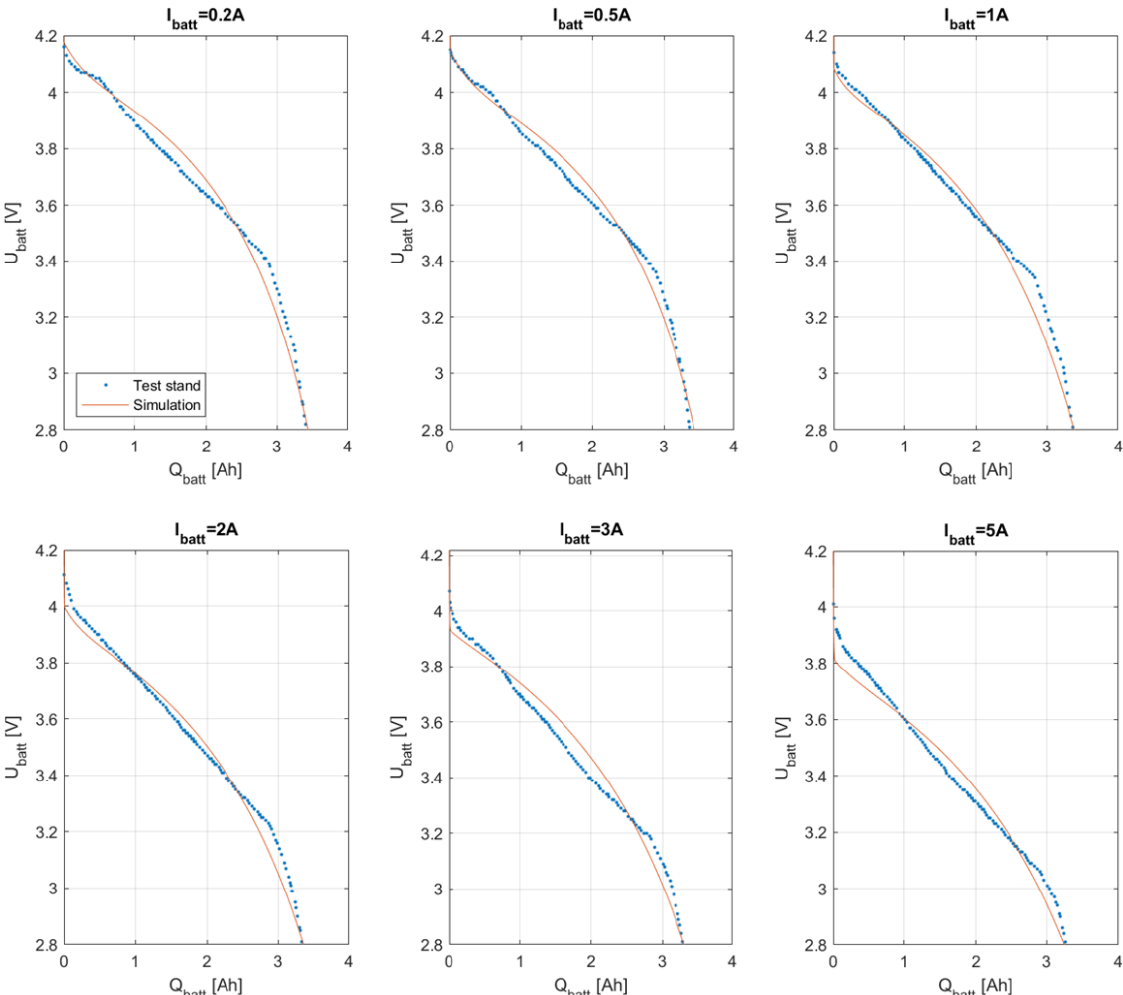
Figure 23. Tuned characteristics of the Samsung INR18650-35E battery simulation model.